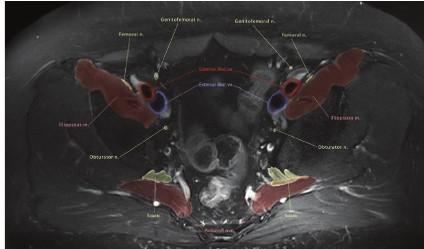
Figure 14: Anatomic illustration using MRN-Axial T2 SPAIR image throughtheupperpelvis withcolor drawing overlay nicely depicting the pelvic neuromuscular